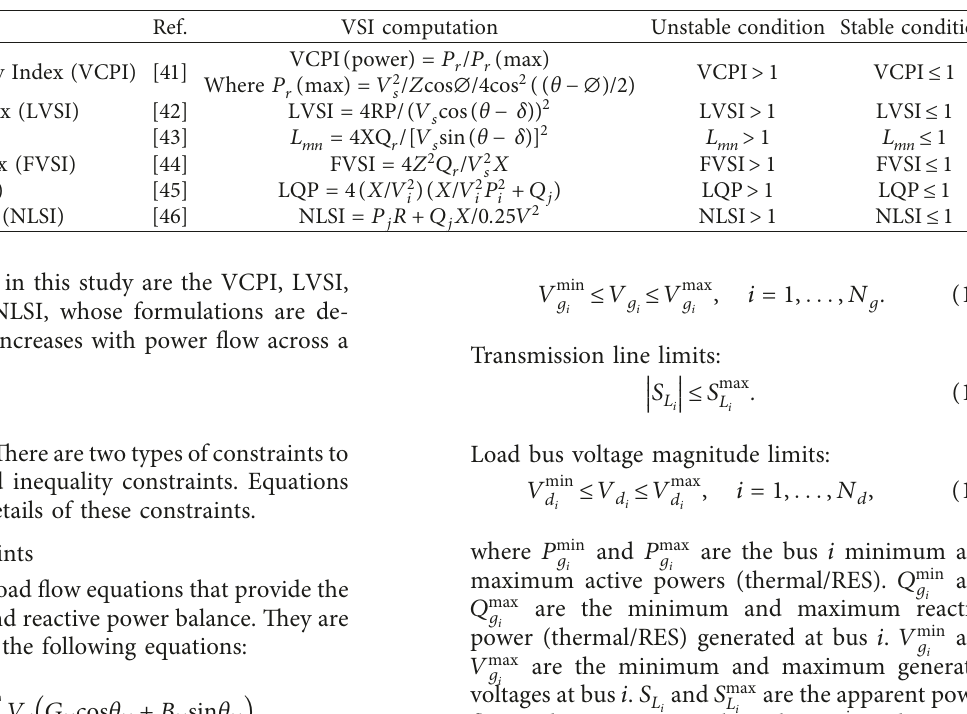
Table 2: Details of the VSIs in the study.